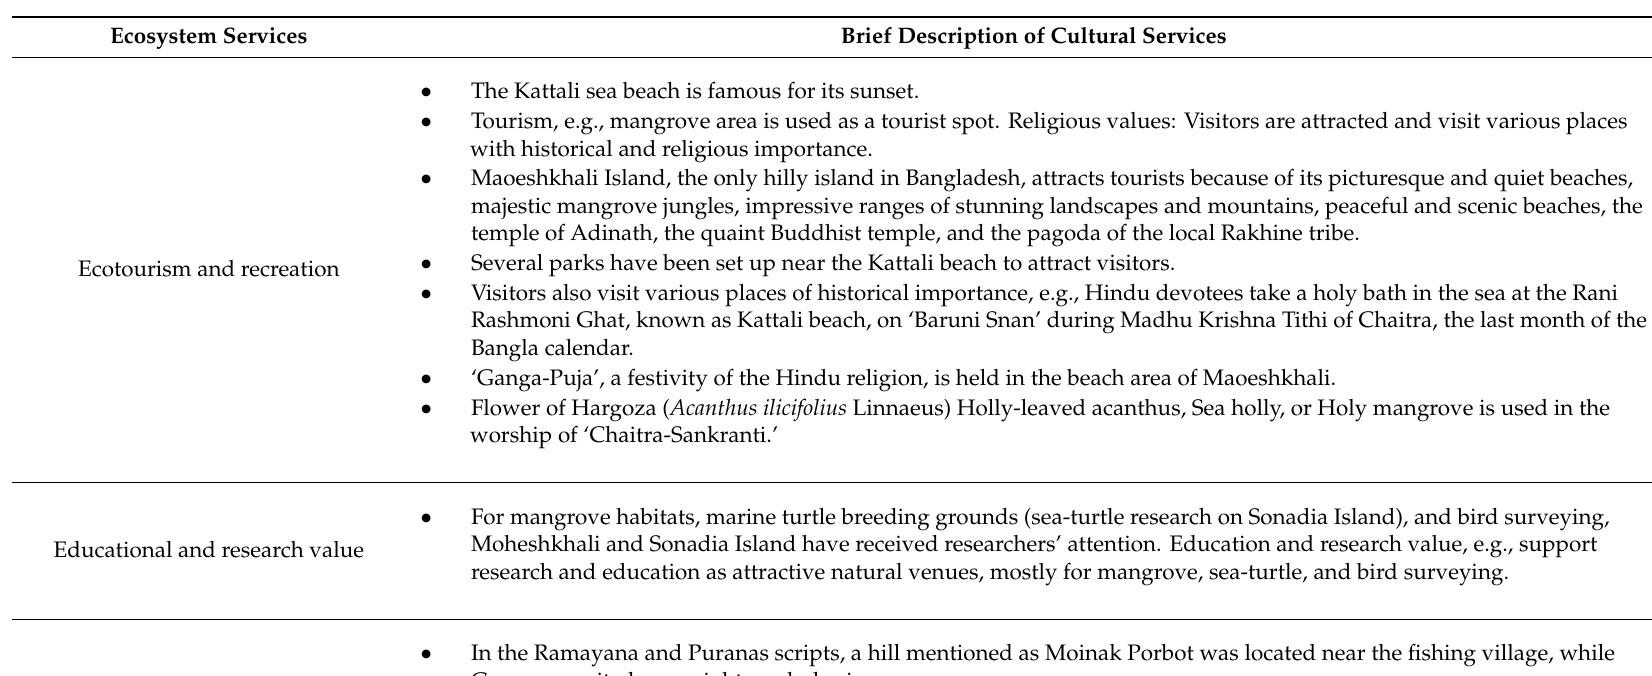
Table 5. Cultural ecosystem services (ES) and other services from the south-eastern coast of